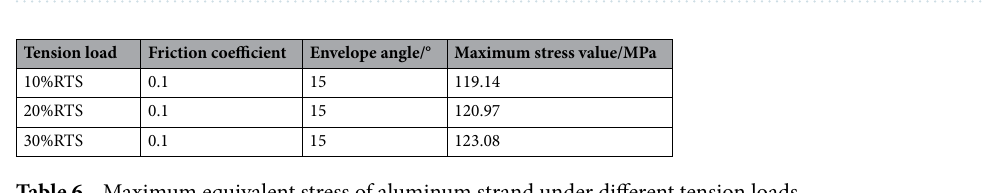
Table 6. Maximum equivalent stress of aluminum strand under different tension